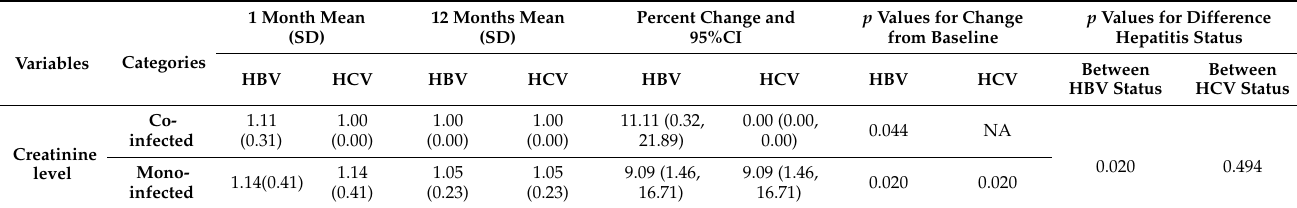
Table 5. Mean creatinine measurements and percent change between 1 and 12 months in HIV/HBV and HIV/HCV co-infected and mono-infected HIV